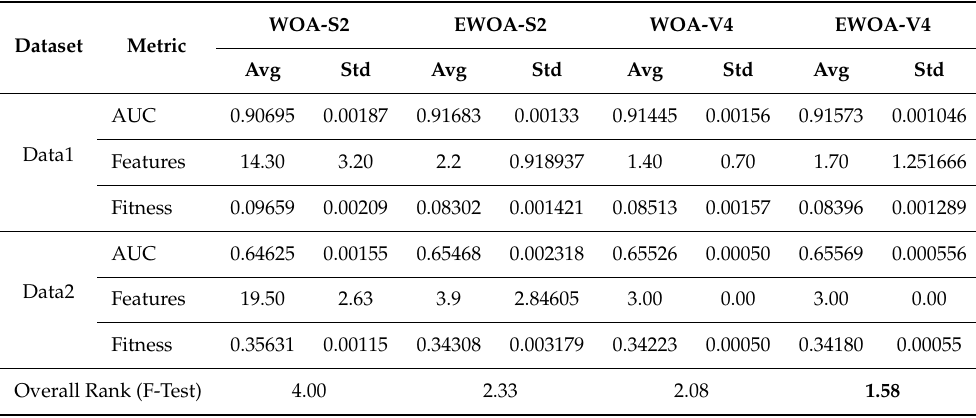
Table 13. Comparison between EWOA and WOA based on best